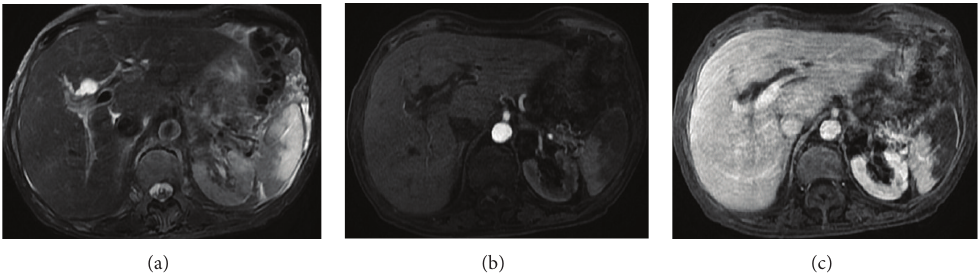
Figure 10: Hematoma. Axial (a) T2wi SSFSE and postcontrast axial T1wi 3D-GRE with fat suppression in the arterial (b) and interstitial (c) phases. A chronic hematoma is depicted with a cystic appearance, regarded as a lesion with moderate hyperintensity on T2wi sequences (a) and hypointensity on T1wi with no perceptible enhancement ((b), (c)).